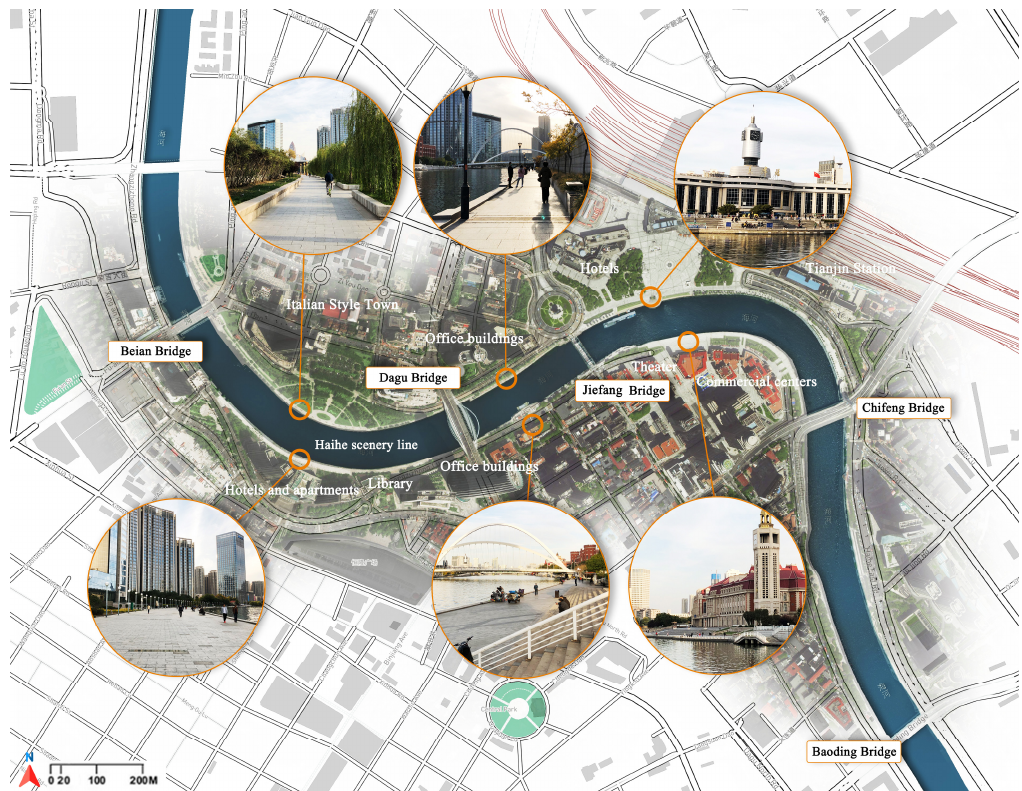
Figure 1. Core area and nodes of Haihe River.